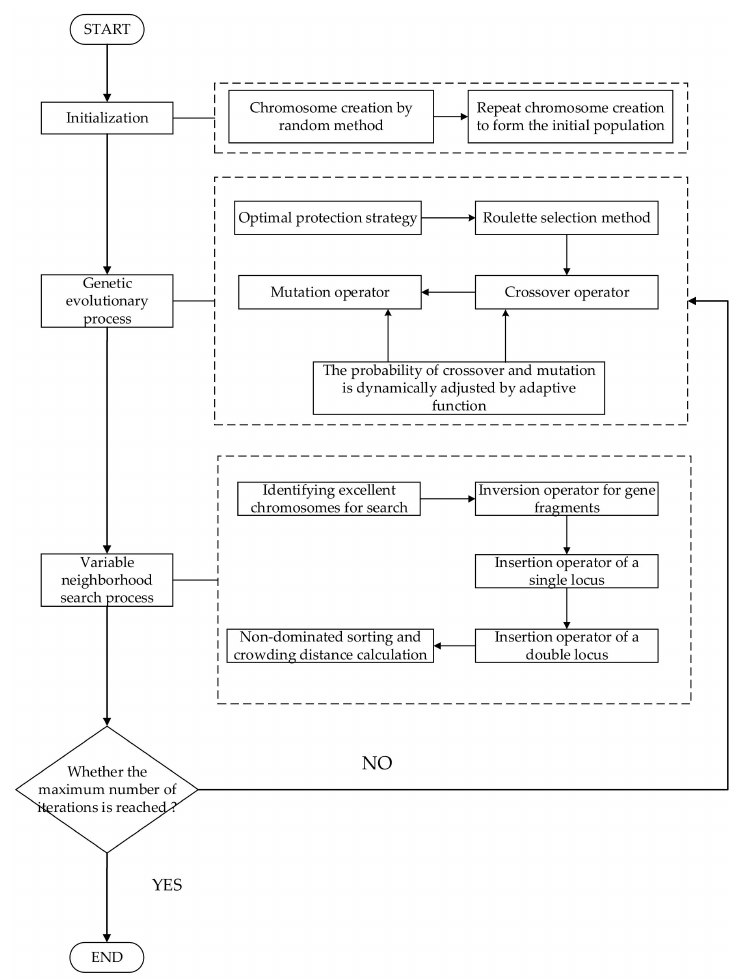
Figure 2. Algorithm flow